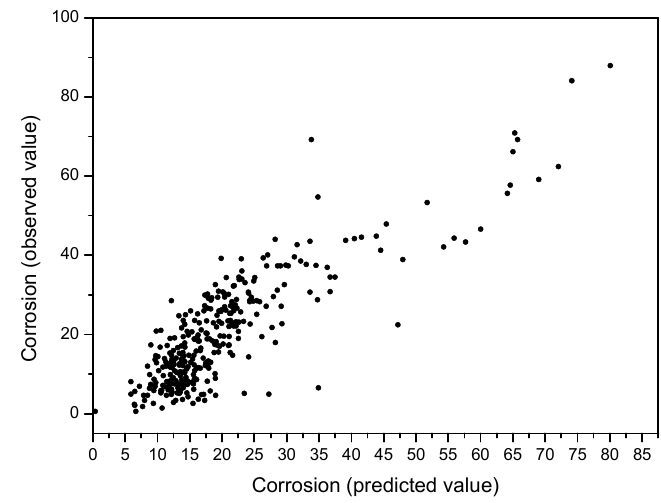
Figure 6. Relationship between predicted and observed carbon steel corrosion values by applying Equation (2).